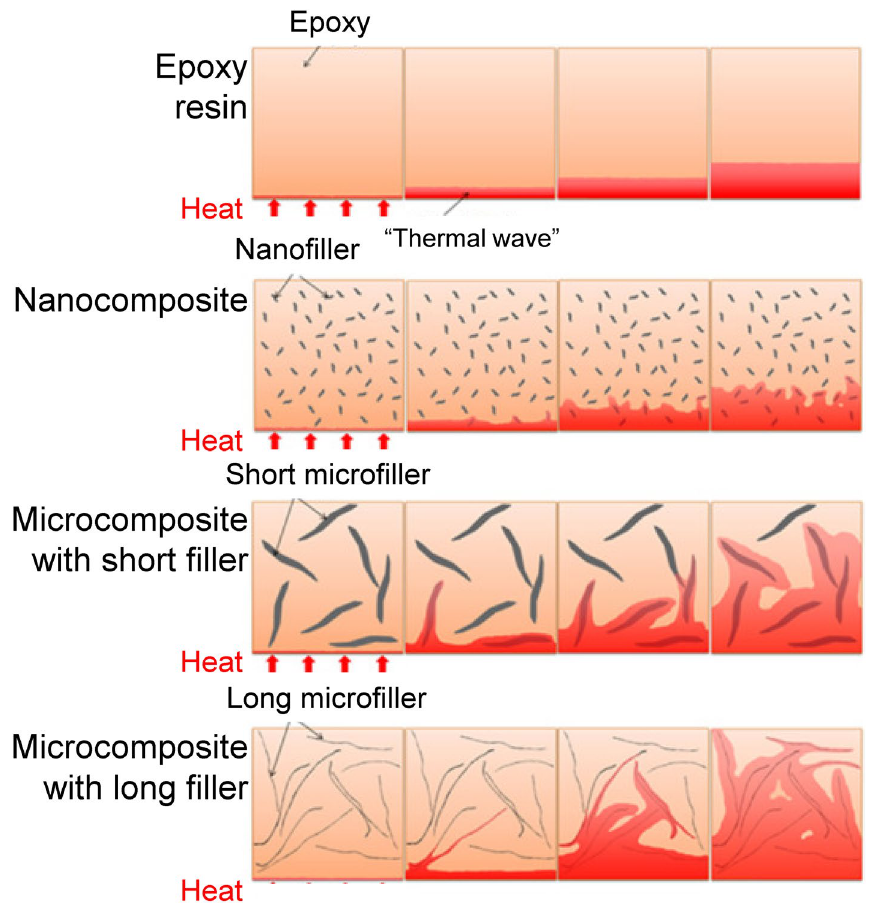
Fig. 3 Schematic illustrations showing the heat transfer in epoxy composites containing fillers with different sizes